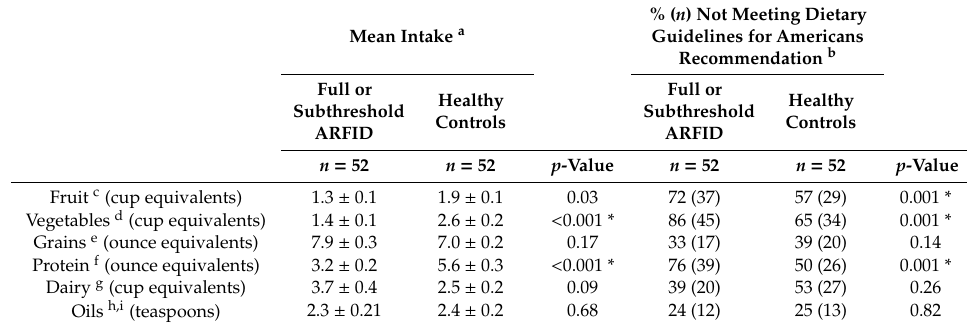
Table 4. Intake among food groups in participants with full or subthreshold ARFID and healthy controls.